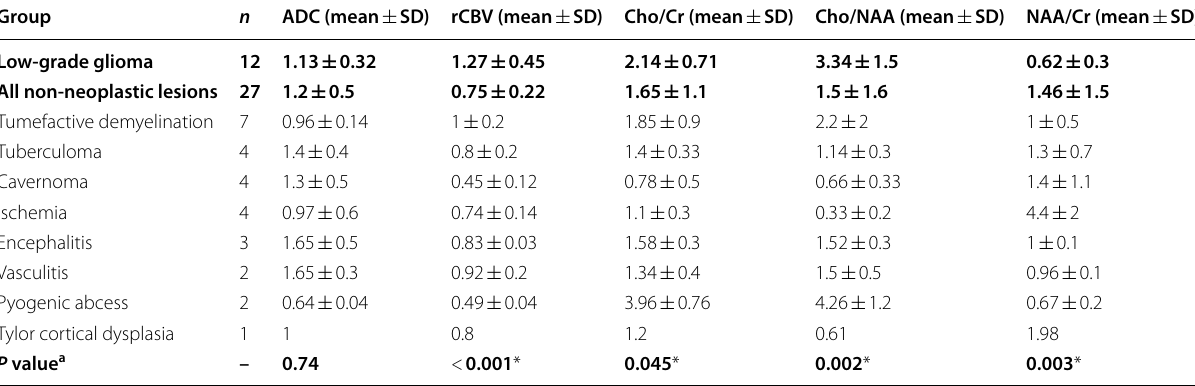
The cut of value and the important numbers are also in bold * Statistically significant a P value for comparison between low-grade gliomas and all non-neoplastic lesions